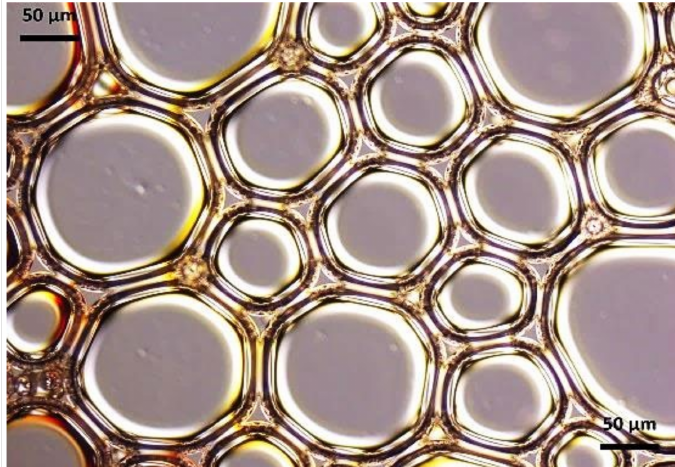
Figure 5. Optical diagram of bubble size structure.